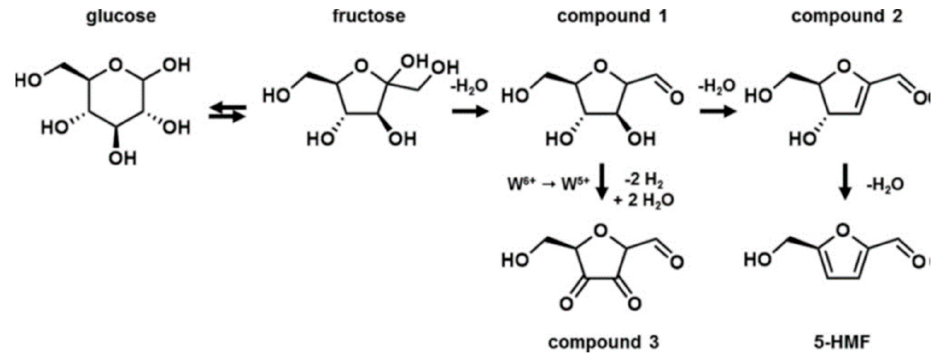
Figure 16. Reaction intermediates in the conversion of glucose to HMF. Reproduced with permission from ref. [140] Copyright © 2016 Wiley Online Library.